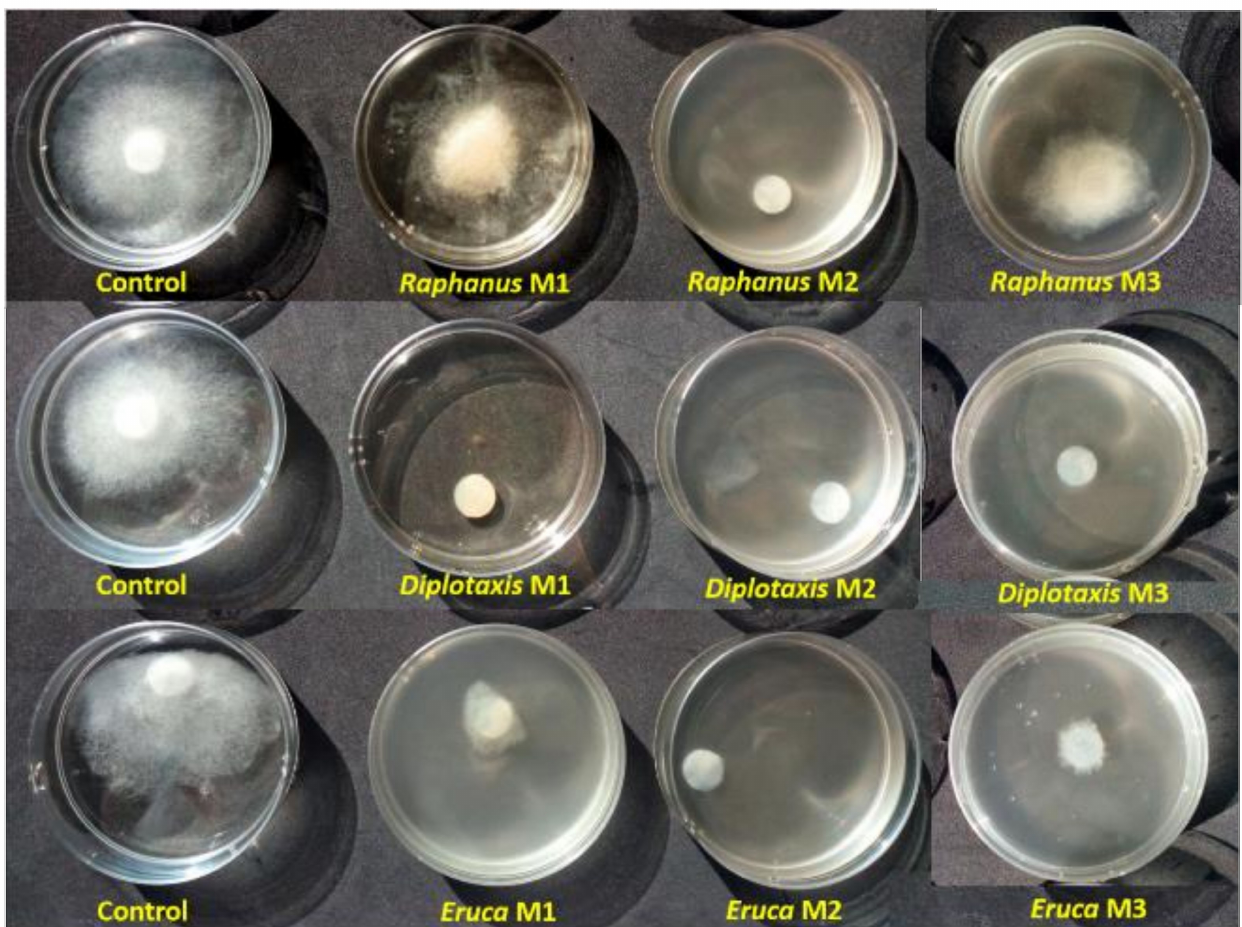
Figure 1. Inhibitory effect of different AREs extracted by three methods (M1, M2 and M3) on Phytophthora cinnamomi mycelial growth in V8 broth after 12 days at 25 ◦ C in the dark. Method 2 (M2) was the most effective in all ARE, and in particular with D. tenuifolia